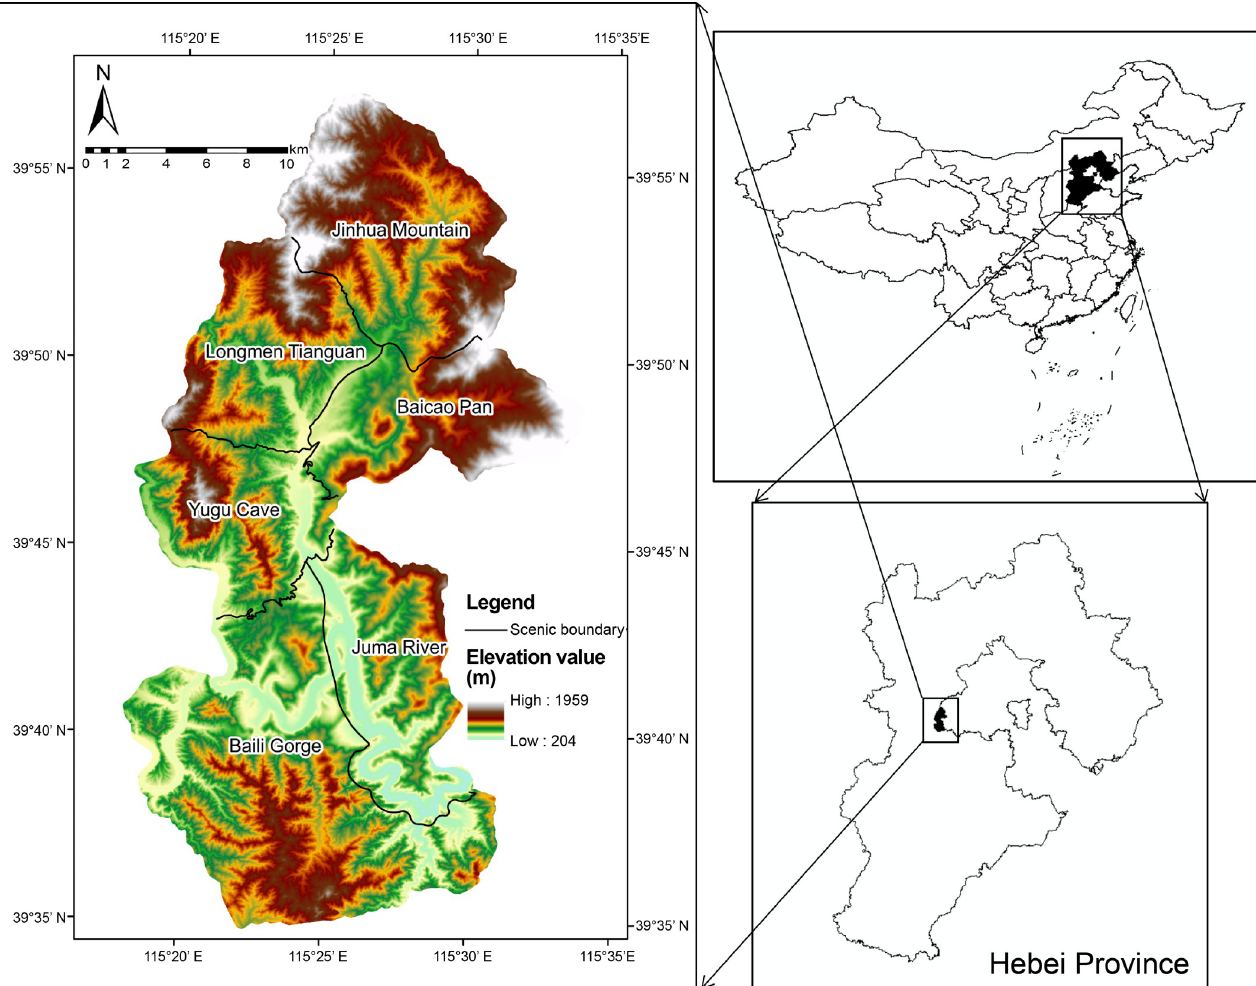
Fig 1. Remote sensing image of the Yesanpo National Park. (Republished from [https://directory.eoportal.org/web/eoportal/satellite-missions/g/gaofen-2] under a CC BY license, with permission from [Hebei Zhongke Sino Star Information Technology Co., Ltd], original copyright [2018]).